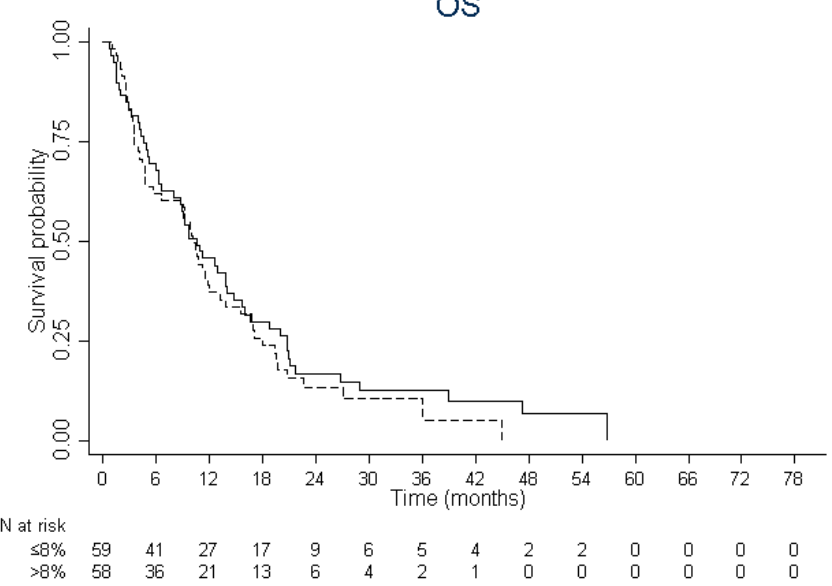
Figure 2. Kaplan–Meier curves for overall survival according to the leukemic stem frequency in patients treated by hypomethylating agents (CD34 + CD38 − CD123 + % ≤ 8%: solid line; > 8%: dashed line).